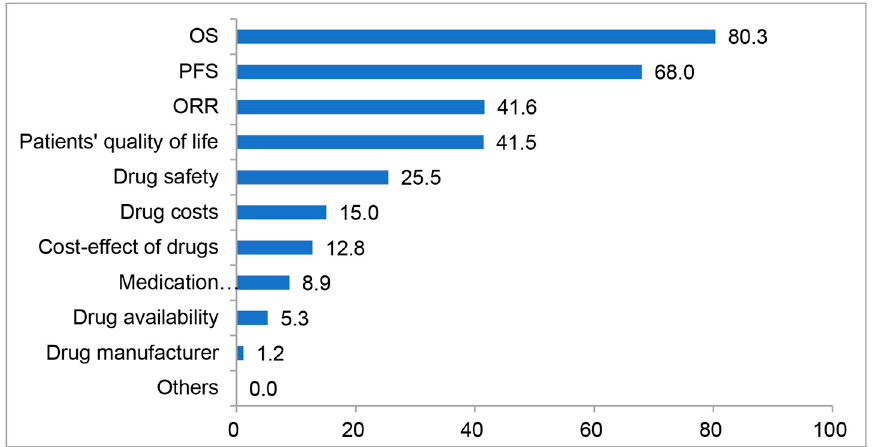
Figure 2. The average score based on the considerations of 495 doctors making treatment plans for HER2-positive metastatic breast cancer patients. (It is a ranking question requiring selection of 5 options, which are rated as 100, 80, 60, 40, 20 scores and 0 score for those are not selected).